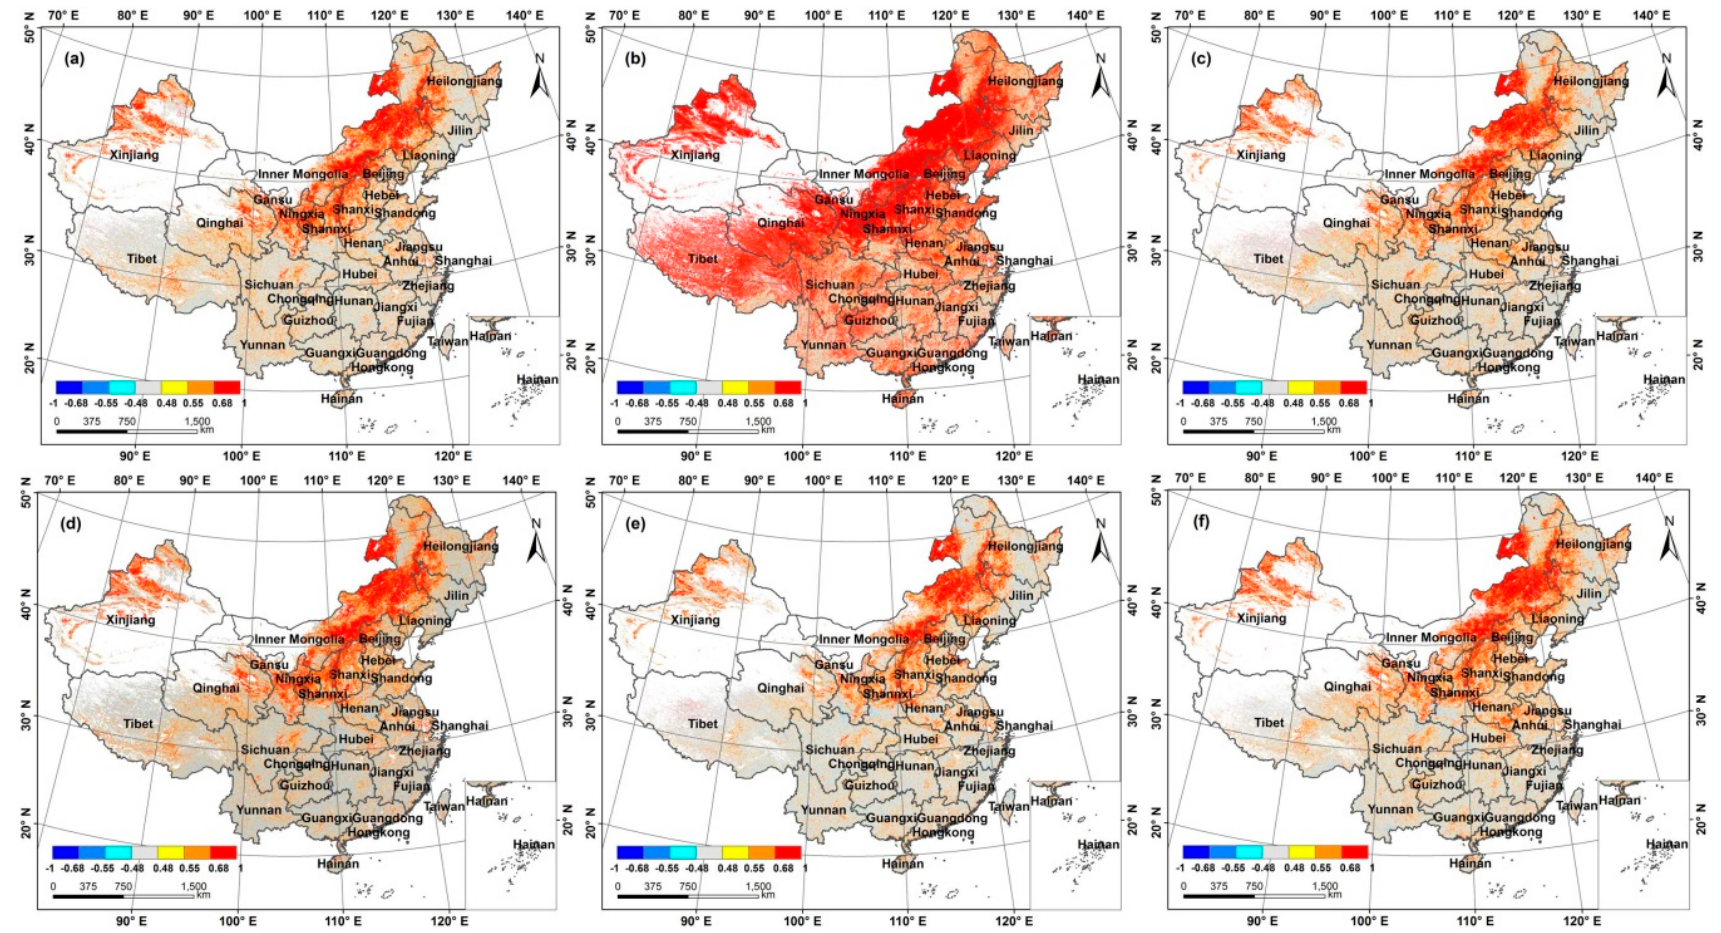
Figure 11. Temporal correlation among each pair of products: ( a ) GLASS vs. MODIS; ( b ) GLOBALBNU vs. MODIS; ( c ) GLOBMAP vs. MODIS; ( d ) GLASS vs. GLOBALBNU; ( e ) GLASS vs. GLOBMAP; ( f ) GLOBALBNU vs. GLOBMAP.